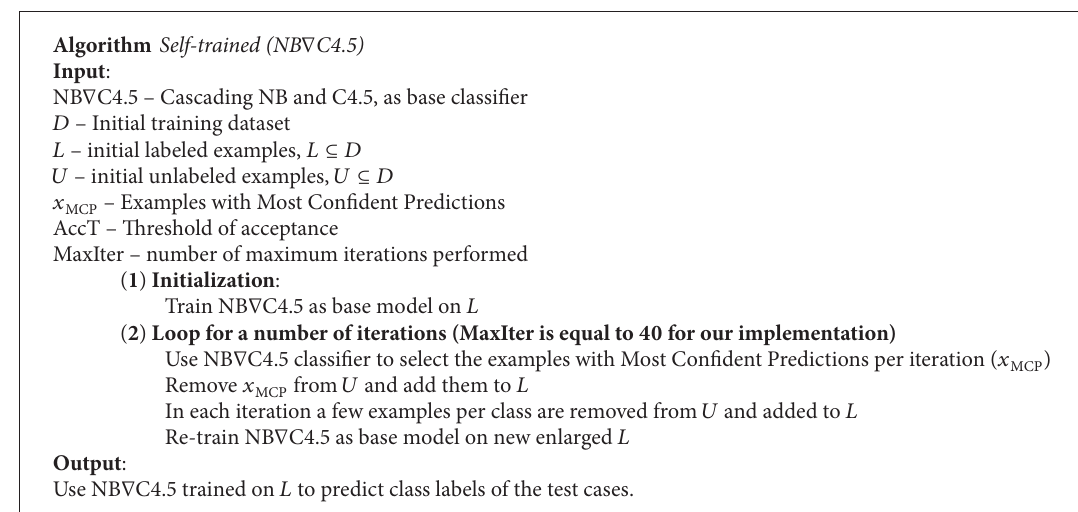
Algorithm Self-trained (NB ∇ C4.5)